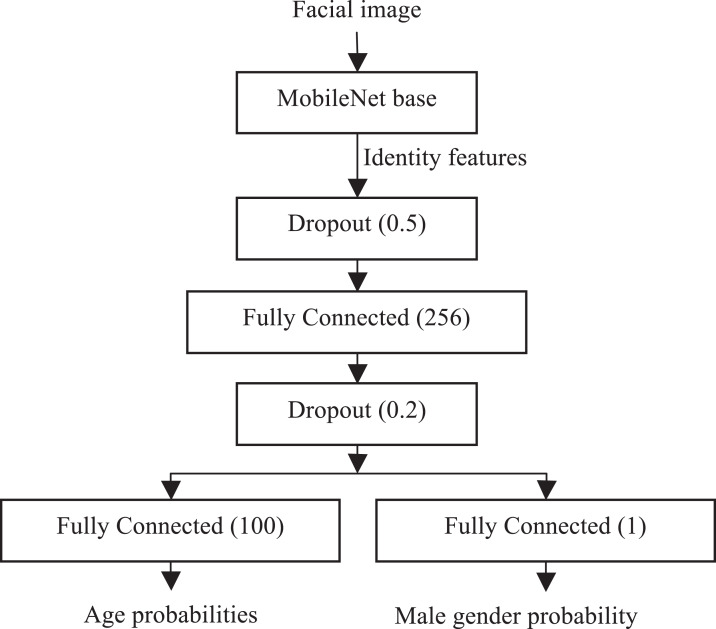
Proposed ConvNet.